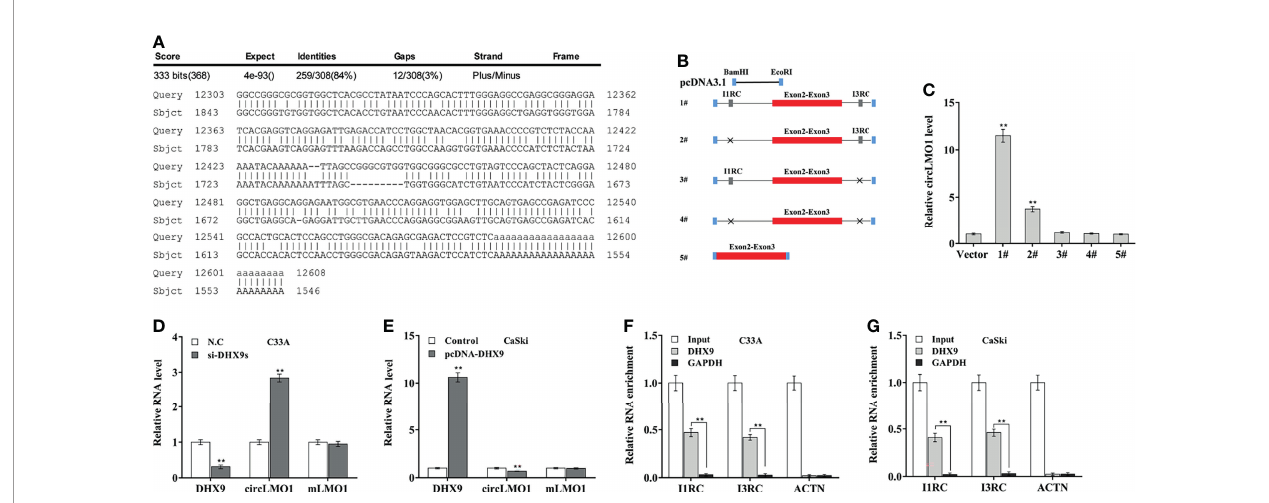
FIGURE 2 | Intron pairing drives the cyclization of circLMO1. (A) Alignment of I1RC and I3RC located in the fl anking intron of circLMO1. (B) Schematic diagram of the recombinant plasmid used to explore the circularization of circLMO1. The genomic region (red bar) of circLMO1 and its wildtype fl anking introns (black line) containing I1RC and I3RC (grey bars) were cloned into the pcDNA vector (1#). A black cross indicates a corresponding absence. (C) qPCR analysis was performed to assess circLMO1 level in CaSki cells treated with different recombinant plasmids (1# to 5#). qPCR analysis of circLMO1 and mLMO1 levels in C33A cells after DHX9 knockdown (D) and CaSki cells after DHX9 overexpression (E) . DHX9 antibody was used for RIP assay to evaluate the direct combination of DHX9 with I1RC and I3RC in C33A (F) and CaSki cells (G) . **p <